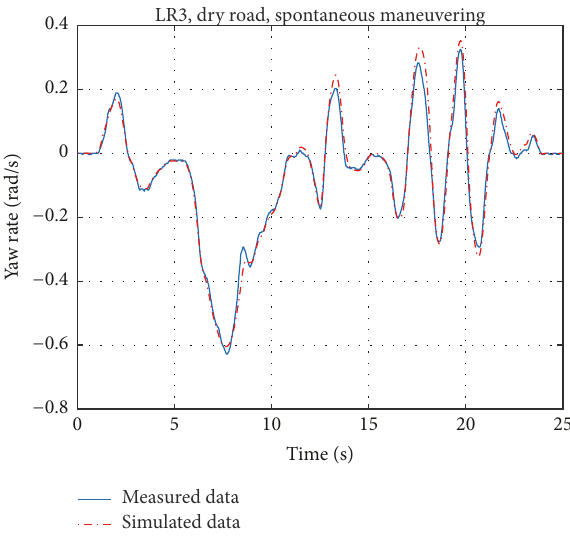
Figure 4: Model validation and comparison of yaw